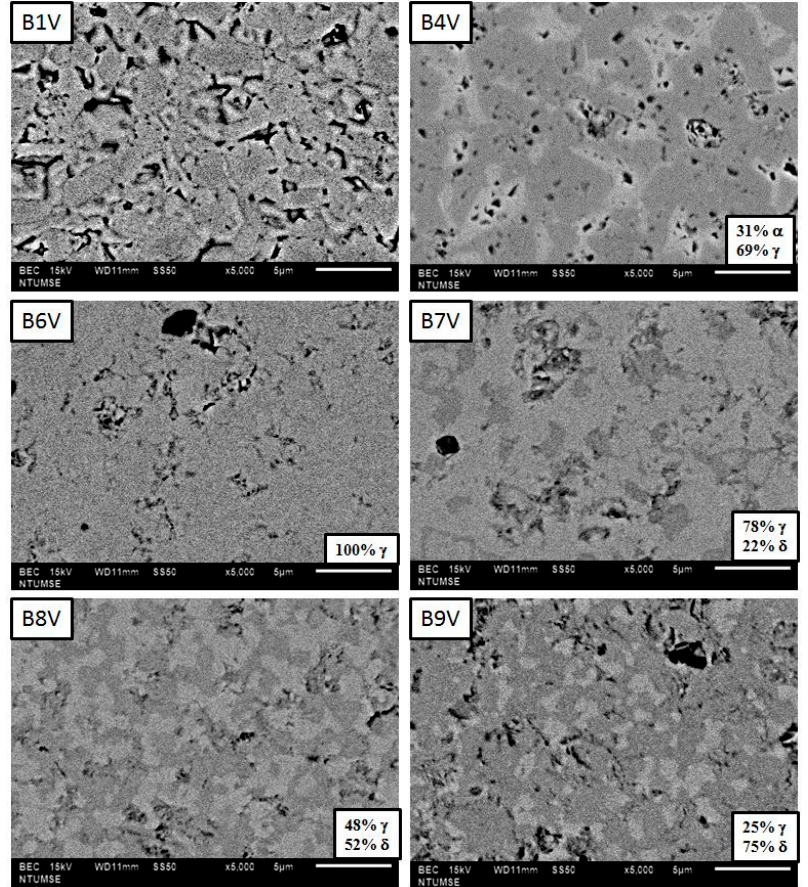
Figure 7. Back-scattered electron (BSE) images of thermal-etched surfaces of B1V–B9V, sintered at 800 °C for 3 h followed by thermal annealing at 680 °C for 100 h. The surfaces have been polished and thermal-etched at 680 °C for 1 h.